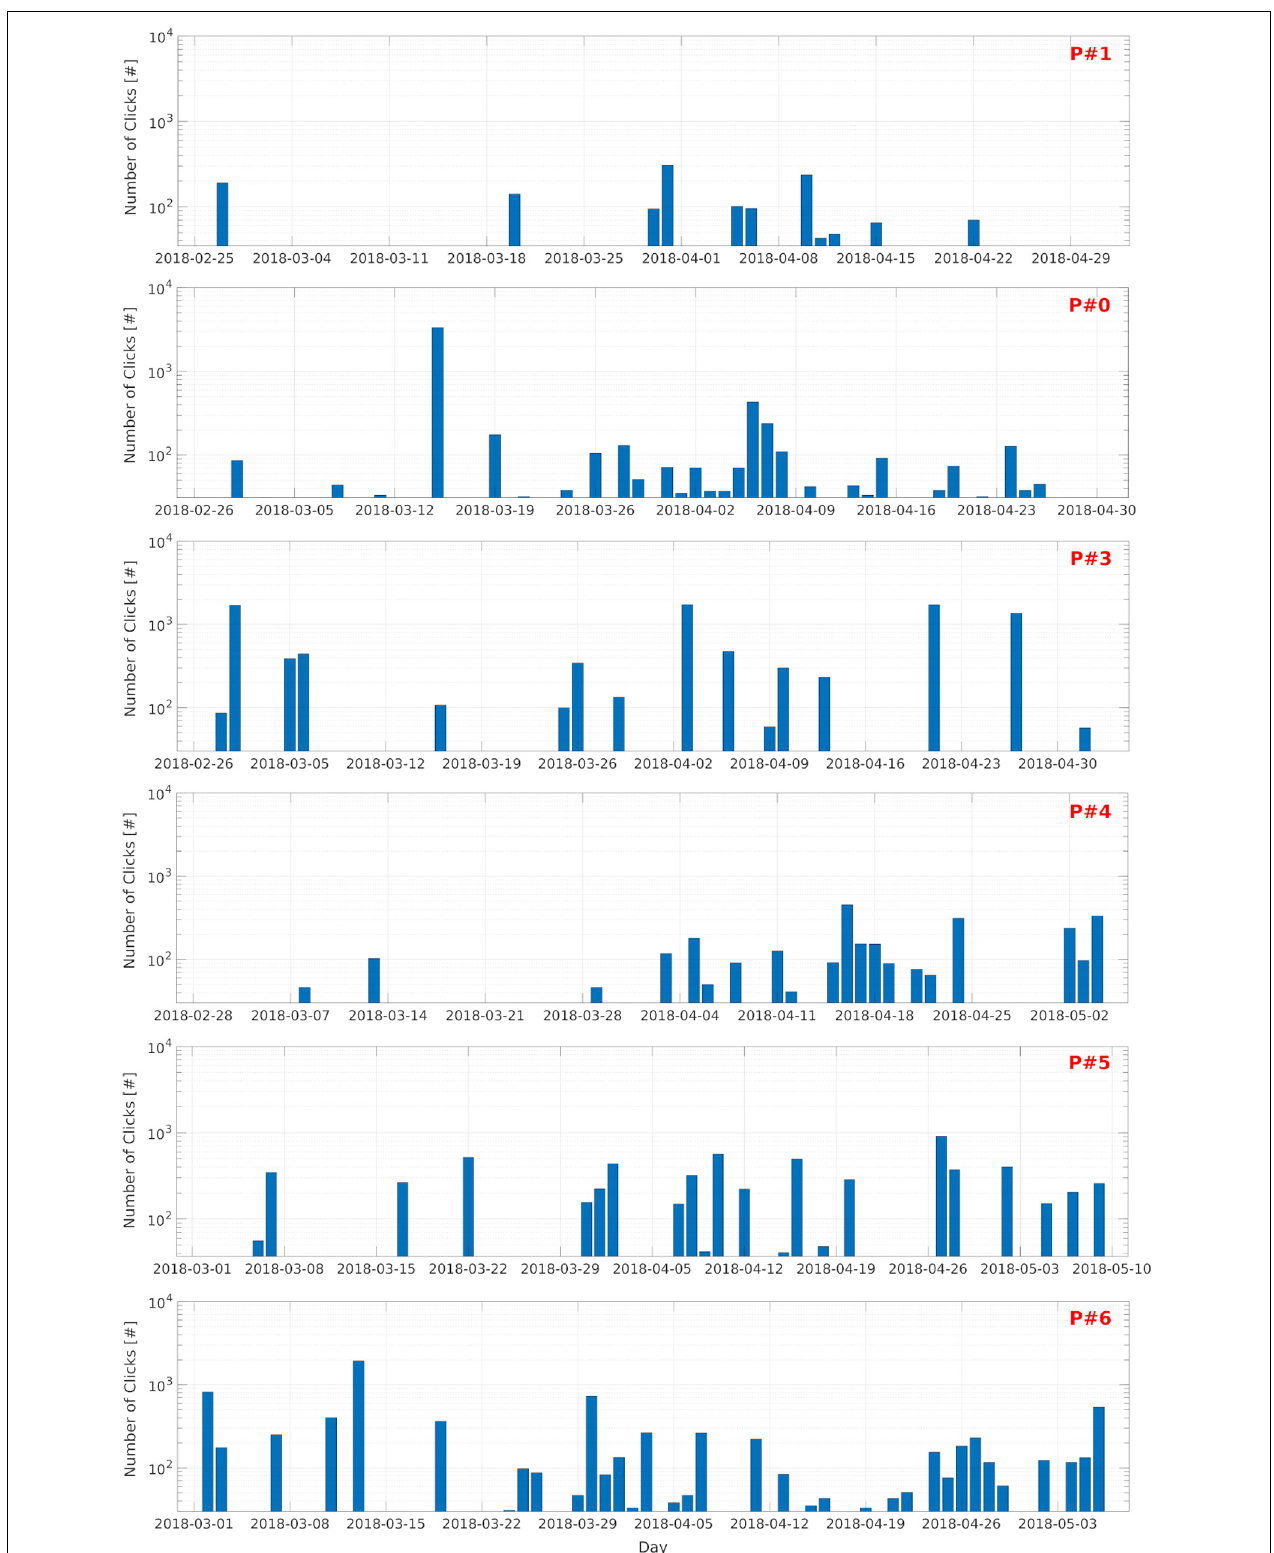
FIGURE 8 | Spatiotemporal distribution. Bar plots showing the number of clicks detected during the study (25 February–10 May 2018) at the PAM sites (P#1, P#0, P#3, P#4, P#5, P#6). Each bar represents the number of clicks detected per day (duty cycle: 5 min every 30 min). Number of clicks ( y -axis) is shown in logarithmic